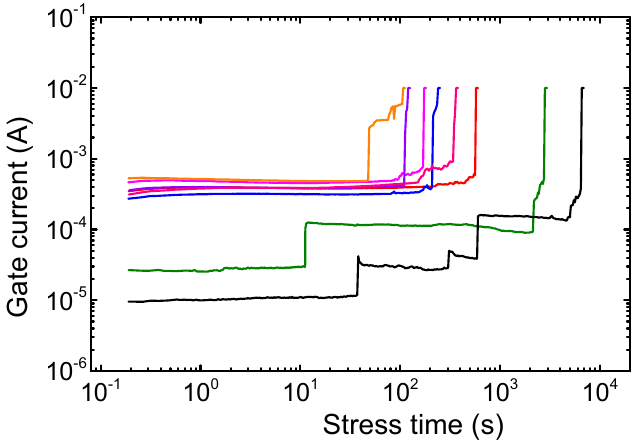
Figure 9. Current variation measured during a constant voltage experiment on identical transistors with p-GaN gate. Stress conditions: V G = 8.5 V, V S = 0 V, drain floating.